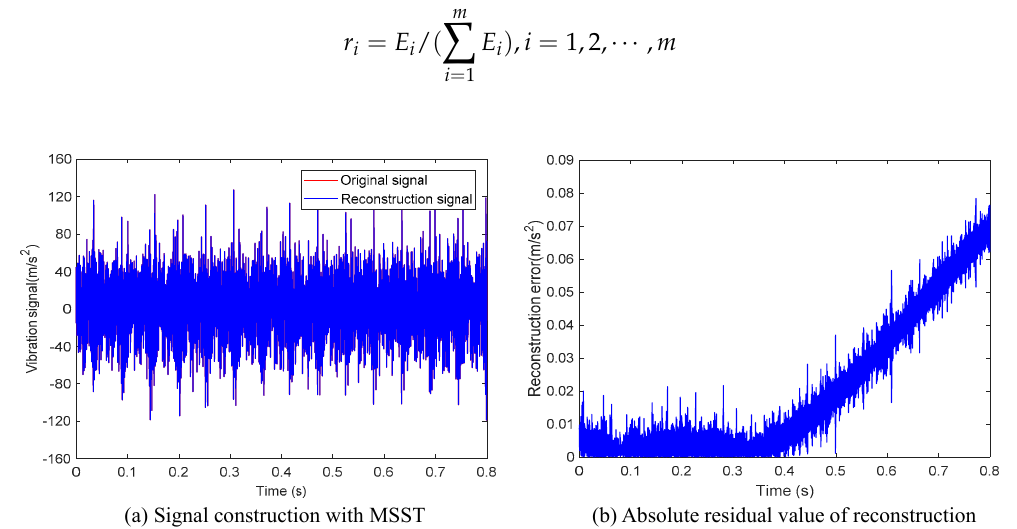
Figure 5. Feature extraction results of frequency bands with two methods.